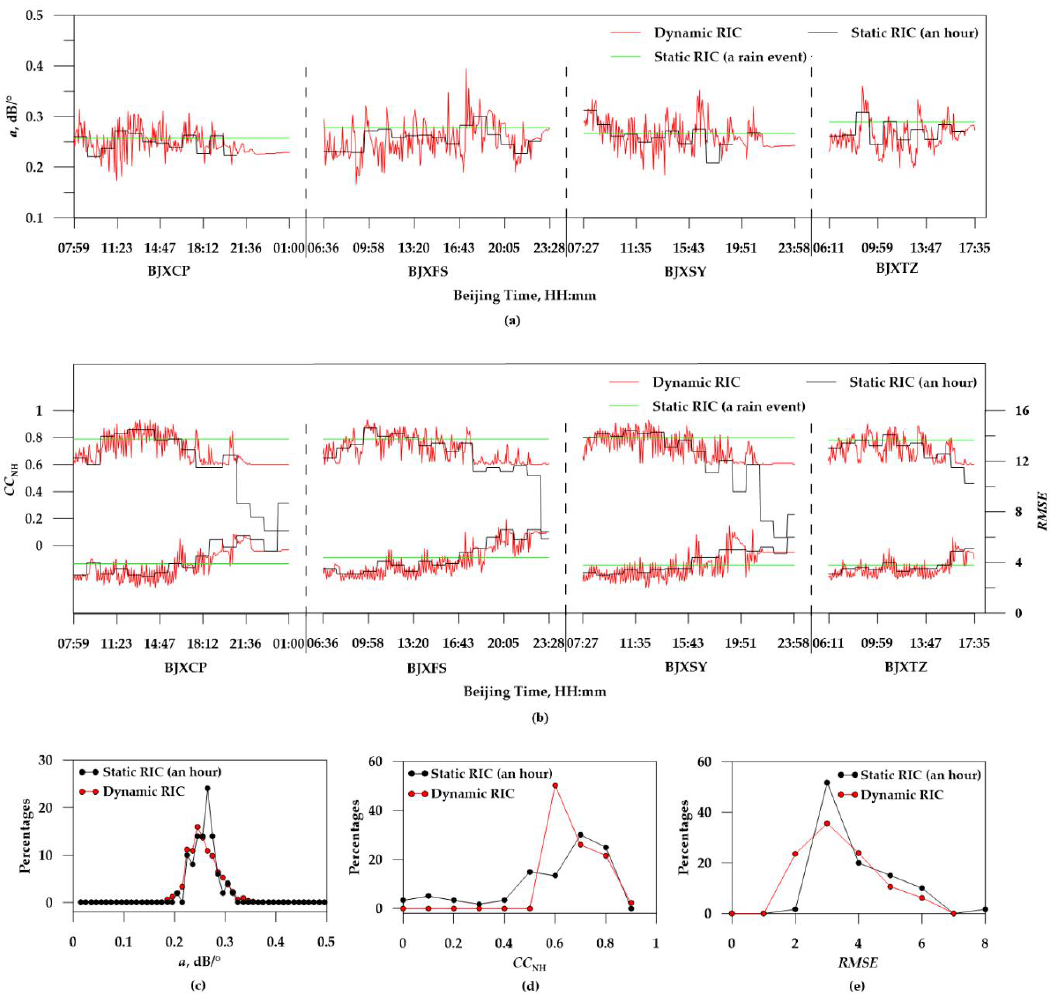
Figure 4. ( a ) Temporal variations of ratio a of BJXCP, BJXFS, BJXSY, and BJXTZ sites in the rain event on 20 July 2016 (Beijing Time). ( b ) Temporal variations of correlation coefficient ( CC NH ; top) and root-mean-square error ( RMSE ; bottom). ( c – e ) Statistics of ratio a in ( a ) and parameters CC NH and RMSE in ( b ), respectively.